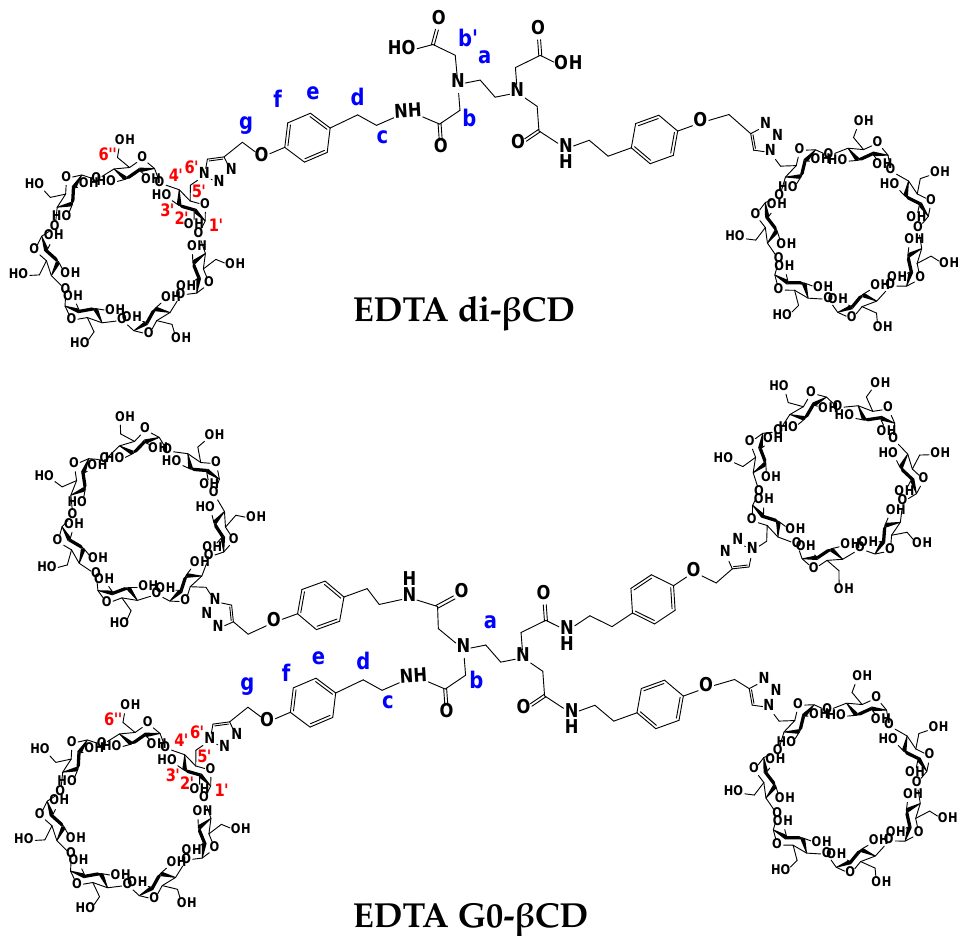
Figure 2. Assignation of the protons in 1 H-NMR spectra for dendritic EDTA di- βCD and EDTA G0- βCD dendrimer.